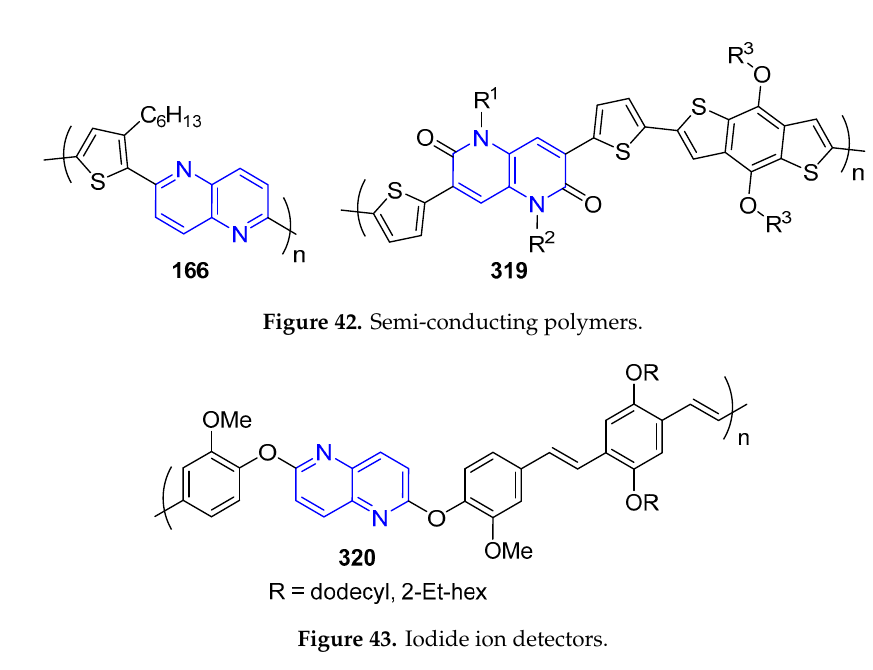
Figure 43. Iodide ion detectors.